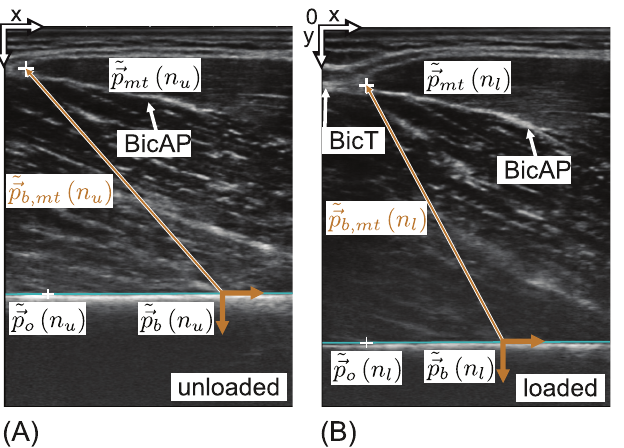
Fig 5. Ultrasonic images of the myotendinous junction (white cross) in the parasagittal plane for the (A) unloaded and (B) loaded case (cmp. Fig 4A, orientation I) are shown. (A) shows the unloaded state n loaded state n l . Reference points ~ ~ p each state. The reference points were used to calculate the position of the myotendinous junction ~ ~ p bone local coordinate system (brown). To calculate the bone surface orientation within the frame, a second marker ~ ~ p was placed arbitrarily on the bone surface. That is ~ ~ p bone line was set such that it included both bone points ~ ~ p